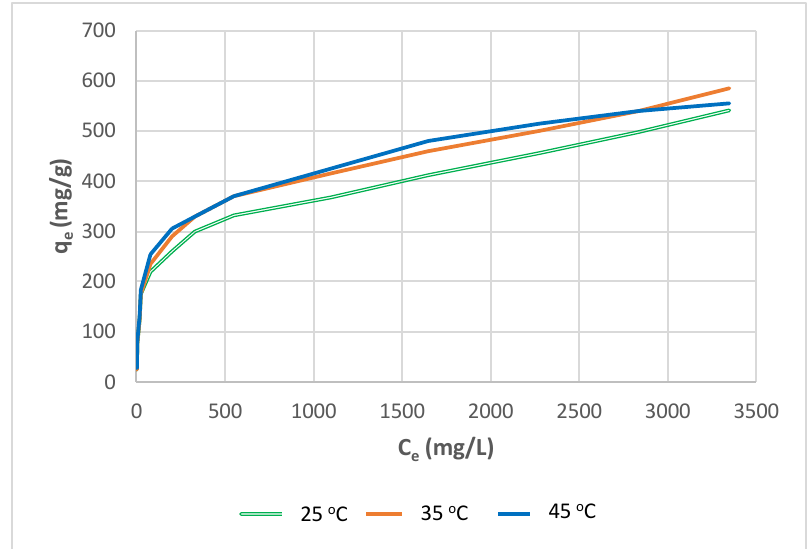
Figure 18. Experimental adsorption isotherms of Direct Yellow RL for SBR achieved at various temperatures (conditions: phase contact time: 180 min, volume: 20 mL, resin mass: 200 mg, agitation rate: 180 rpm).